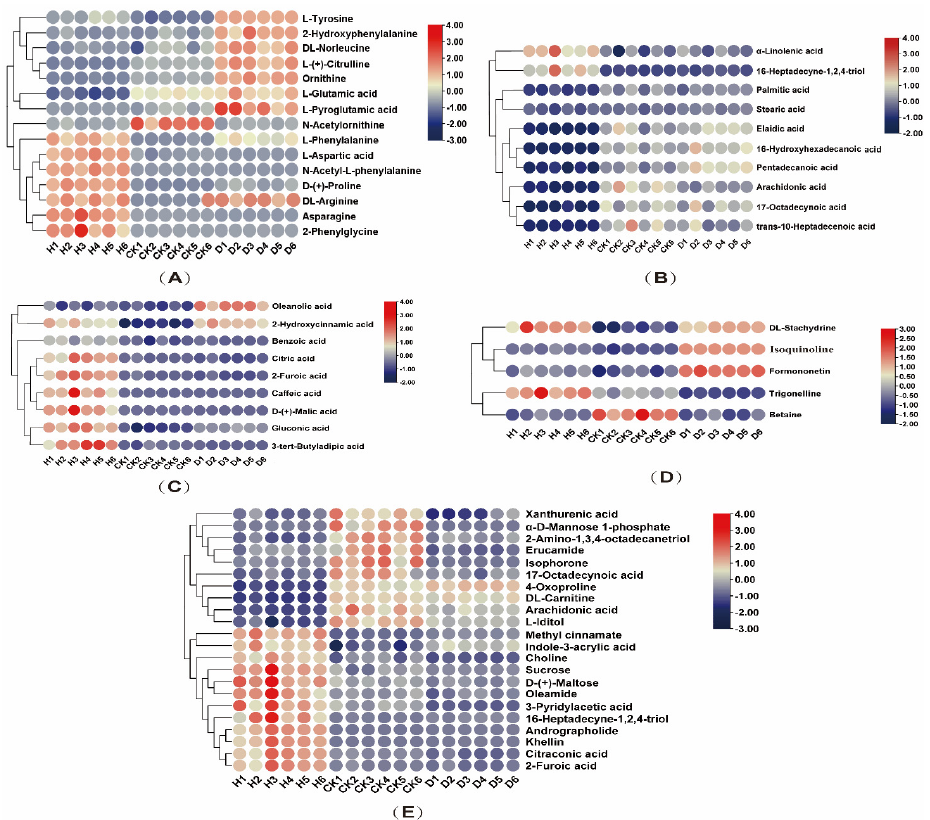
Figure 7. Heatmap analysis for the identified metabolites with a significant difference screened by OPLS-DA (VIP > 1) and ANOVA ( p < 0.05). ( A ) Amino acid and its derivatives; ( B ) fatty acid; ( C ) organic acid; ( D ) secondary metabolites; ( E ) other. H treatment: P852 at 10 μ g/mL, D treatment: 1 μ g/mL of P852, and CK: sterile water to treat Fusarium wilt and the roots of Faba bean. Aromatic amino acids (Trp, tyrosine, and Phe) are involved in the shikimate-phe- nylpropanoid pathway, betaine biosynthesis pathway, and auxin biosynthesis, as shown in Figure 7. Compared with the control group, the content of aromatic amino acids was increased by H treatment, whereas D treatment was relatively reduced, consistent with the study of Pan et al. [28]. Cucumbers treated with pesticides had a higher concentration of aromatic amino acids in their fruit [23], a finding that may have stimulated the shiki- mate-phenylpropanoid pathway of auxin biosynthesis [58]. Both D and H treatments in- duced auxin biosynthesis, of which tryptophan is a key component, providing a mecha- nistic basis for the enhancement of plant growth and biomass accumulation. This finding is congruent with previous studies that demonstrated flavonols affecting auxin synthesis, thereby promoting plant growth and development [59]. Furthermore, the metabolome revealed the alteration in fatty acid composition in Fusarium wilt-infected Faba bean leaves under the H and D treatments of P582. The con- tents of α -linolenic acid and 16-heptadecene-1,2,4-triol in Faba bean leaves were increased under the H treatment. In contrast, the fatty acid composition in the D treatment group